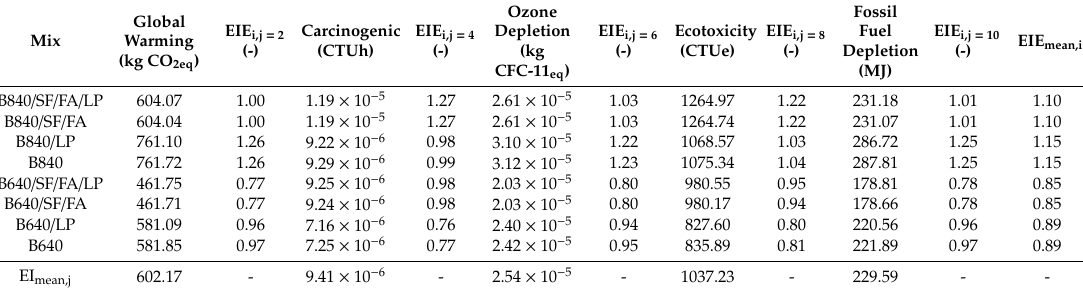
Table 7. Comparison of the Environmental Impact of mixes.